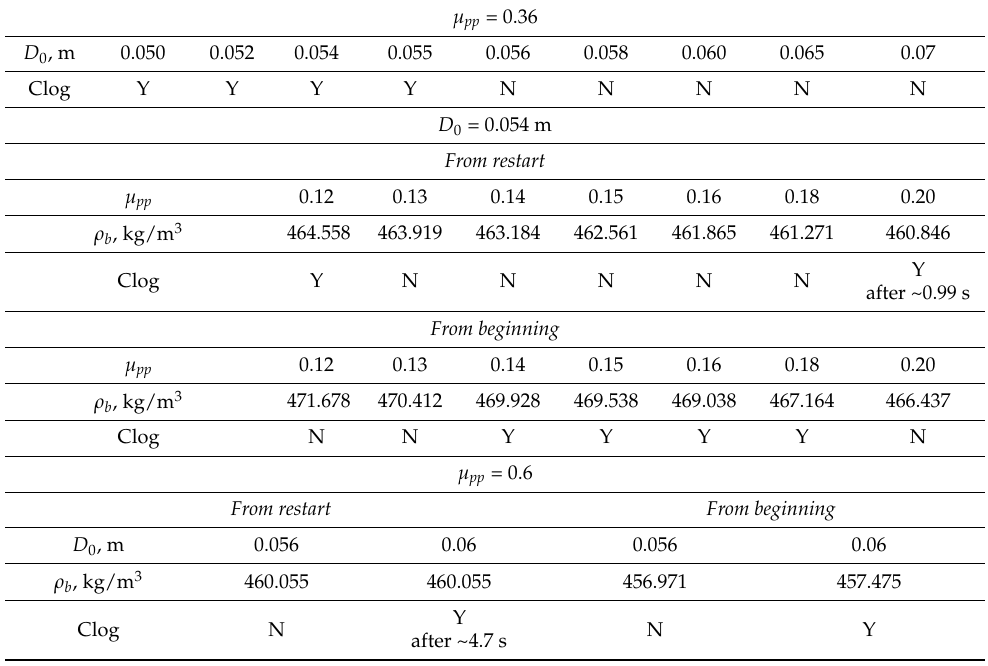
Table 2. Dependence of bulk density ρ b and occurrence of the clogging process (Y—clogging, N—no clogging) on the orifice size D 0 and the particle–particle friction coefficient µ pp . µ pp =